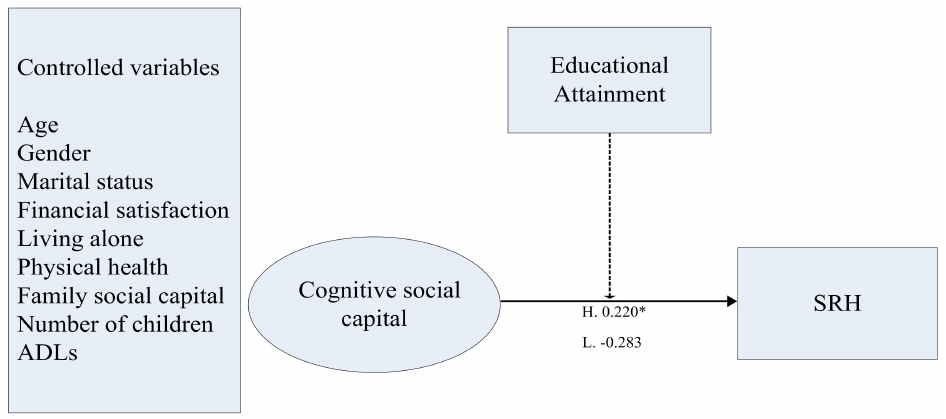
Figure 1. Final model of the role of educational attainment in the relationship between CCSC and self-rated health (SRH). Notes: standardized coe ffi cients are reported. The dashed line indicates a moderating e ff ect; * p < 0.05